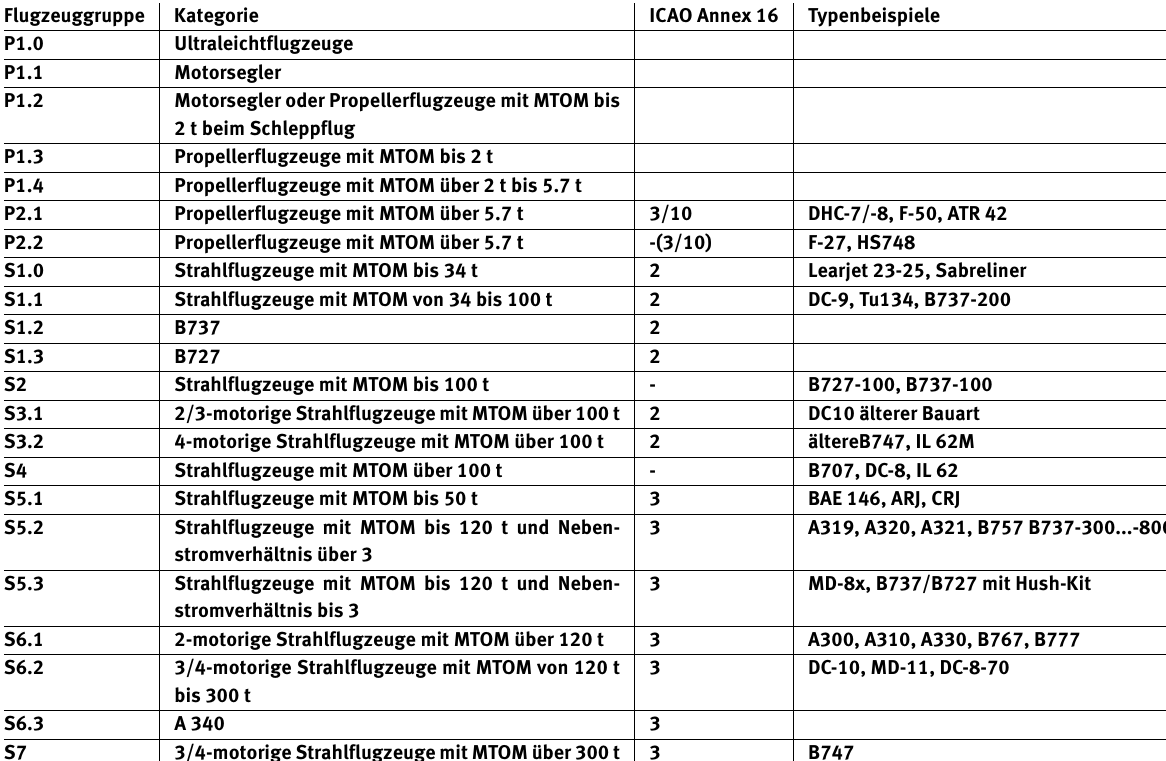
Table 2. Aircraft categorisation as per